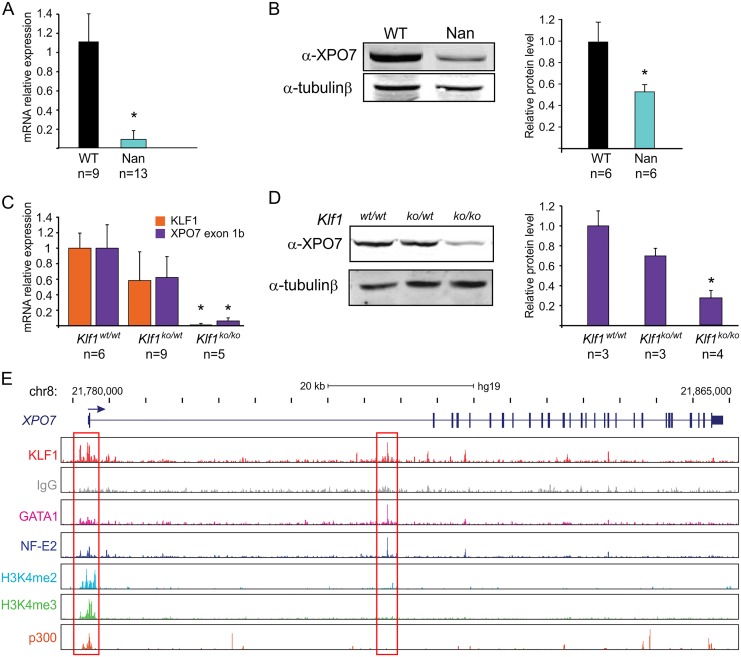
XPO7 expression in wildtype, Nan and Klf1 knockout fetal liver cells.(A) Xpo7 mRNA relative values in wildtype and Nan E14.5 fetal livers. * indicates p value <0.01. n indicates the number of embryos. (B) Western blot analysis of XPO7 protein in wildtype and Nan E14.5 fetal livers and quantification. β-tubulin was used as loading control. * indicates p value <0.01. n indicates the number of embryos. (C) Klf1 and Xpo7 mRNA relative expression values in wildtype, KLF1 heterozygotes and KLF1 knockout E13.5 fetal livers. * indicates p value <0.01. n indicates the number of embryos. (D) Western blot analysis of XPO7 protein in wildtype, Klf1 heterozygotes and Klf1 knockout E13.5 fetal livers and quantification. β-tubulin was used as loading control. * indicates p value <0.01. n indicates the number of embryos. (E) KLF1, GATA1, NF-E2, H3K4me2, H3K4me3, and p300 ChIP-seq data for the human XPO7 locus. KLF1 peaks in the region of the canonical XPO7 promoter and in the first intron are indicated by a red box. Data taken from [38].